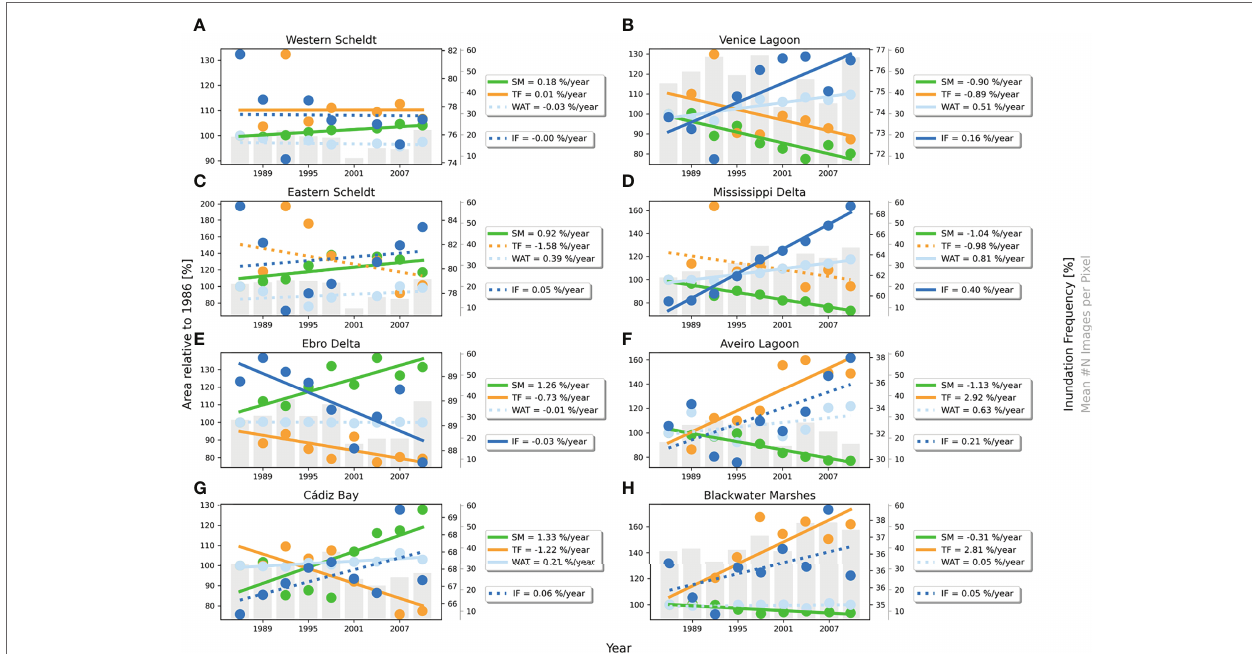
FIGURE 3 | Time series of saltmarsh (SM), tidal flat (TF), and water (WAT) area [%] for each study site (left y-axis) and of inundation frequency [%] (right y-axis). Mean number of unmasked images per pixel of each 3-year bin is shown by the gray bars in the background (second right hand y-axis). Study sites with expanding saltmarshes are shown in the left column, and those with retreating saltmarshes in the right column. Significant trends are given with a solid line, non-significant trends are indicated by a dashed line. The slope, i.e., yearly change, is indicated in the